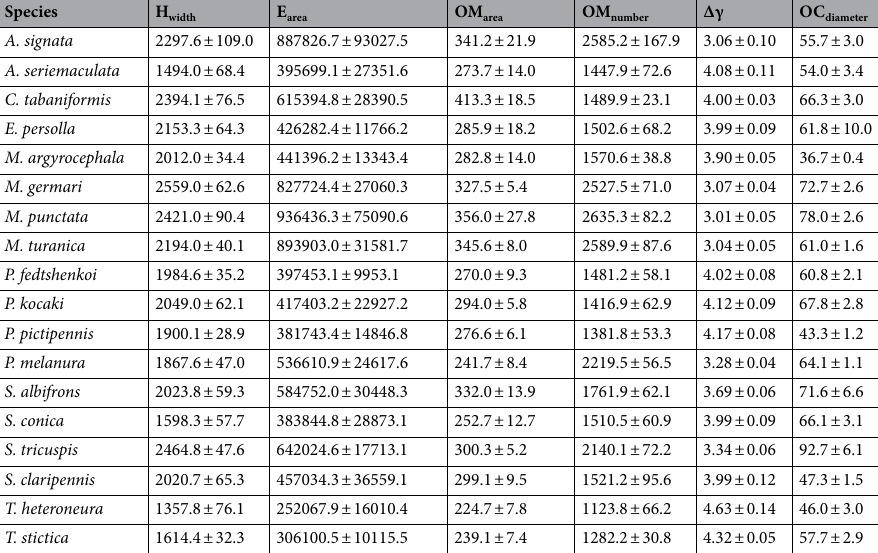
Table 1. Mean ± Standard Error of the head width and the five morphological variables associated with the visual sensory system, calculated across individuals for each species. All measures are in µm (linear) or µm 2 (area). H head, E eye, OM ommatidia, OC ocelli, ∆ γ interommatidial